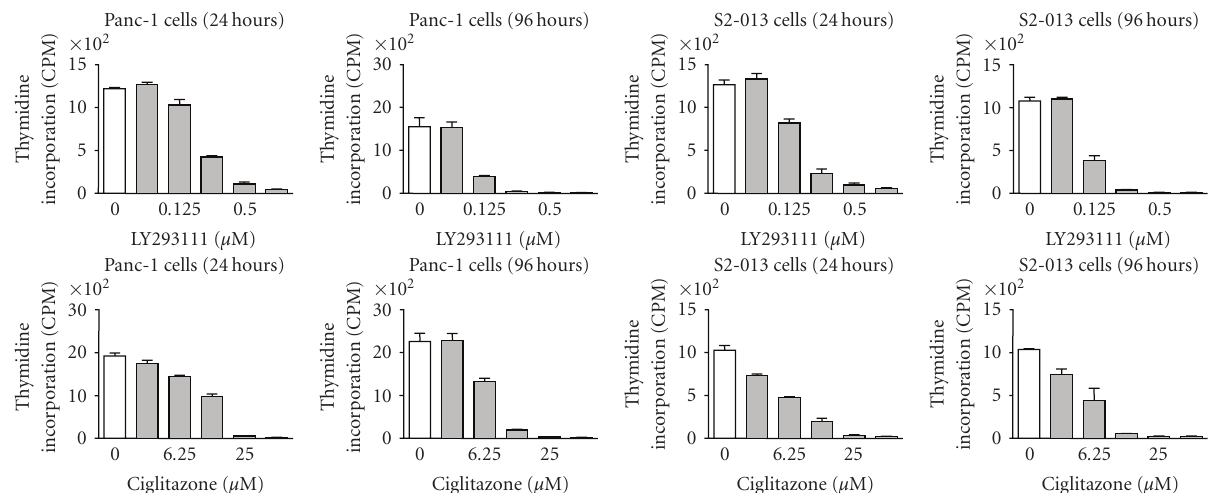
Figure 2: Comparison of the e ff ects of di ff erent concentrations of LY293111 and ciglitazone on proliferation of two human pancreatic cancer cell lines (Panc-1 and S2-013) after 24 and 96 hours of treatment, measured by thymidine incorporation. LY293111 was approximately 50 times more potent than ciglitazone at inhibiting proliferation of both cell lines. Data shown is mean ± SEM from four separate